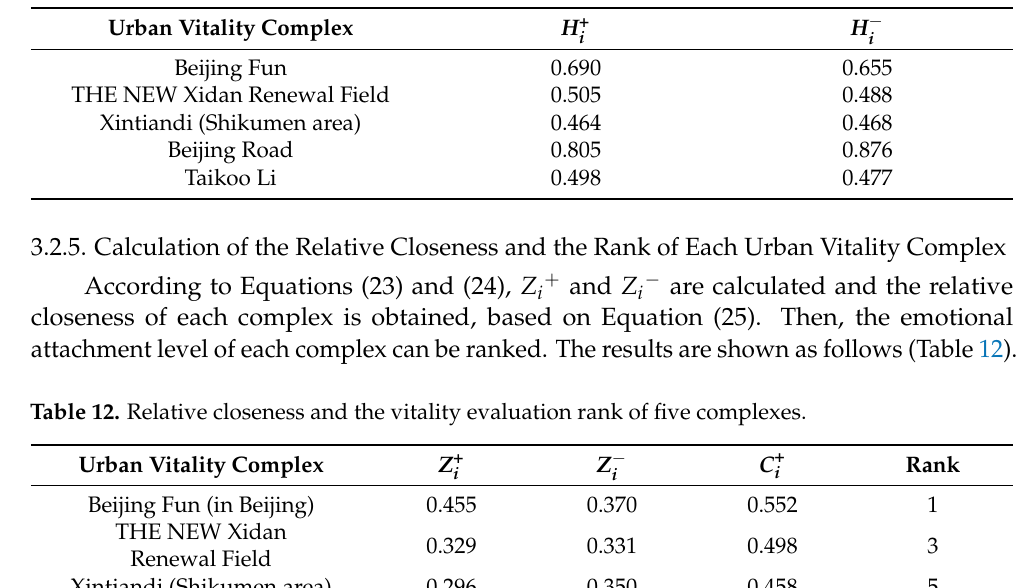
Table 11. Grey relational degree of each complex.